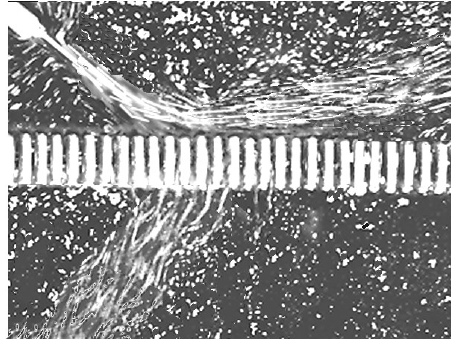
Fig. 7. Another flow visualisation of the obliquely impinging jet. The impinging jet angle  X is here smaller than the corresponding one in Fig. 4 – and this has led to the visibly larger is the angle  Z .